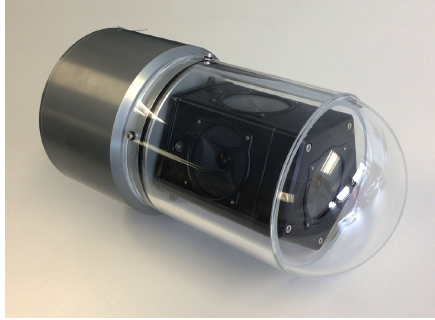
Figure 2. Final design of the omnidirectional underwater camera.